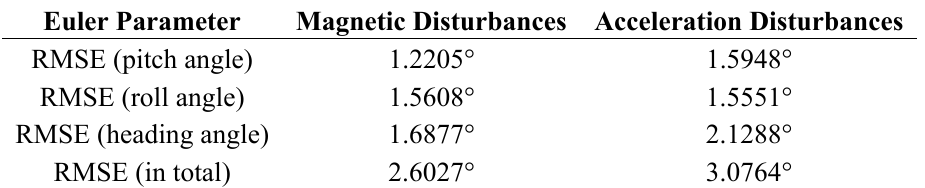
Table 2. The RMSE of AFQC with disturbances.